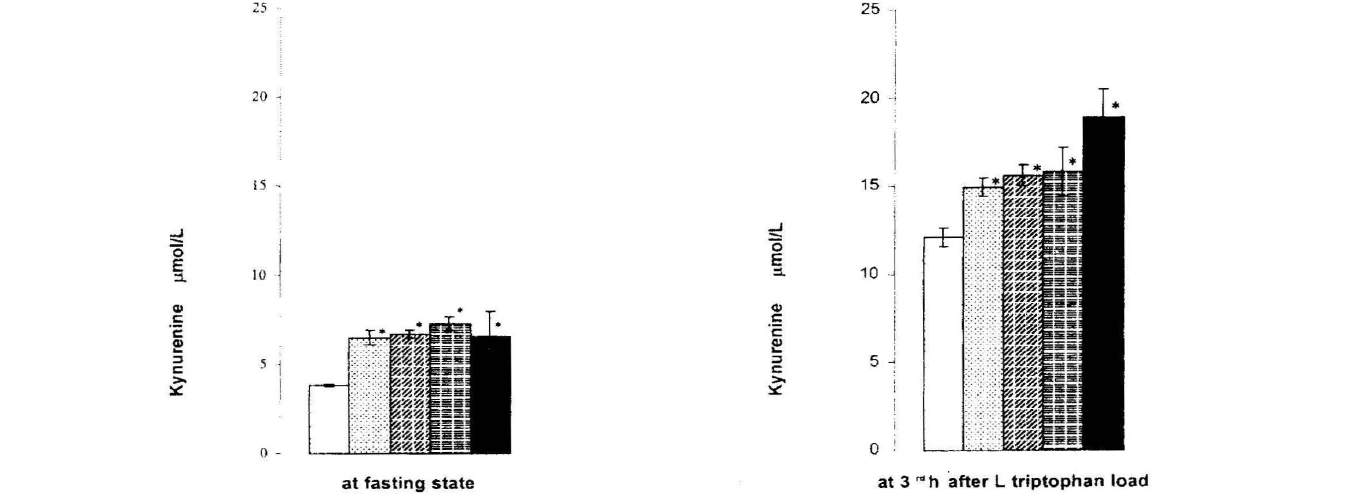
Figure 2. Concentrations (mean ± S.E.) of serum kynurenine at fasting state and at 3rd h after 30 mg L-trypto phan/kg body weight load in healthy individuals (open bars) and in CHD patients before PTCA due to balloon angioplasty (dotted bars), 1 st time stent implantation (hatched bars), repeated stent implantation (striped bars) and restenosis (black bars).*The changes are statistcally significant (P <0.02 - P